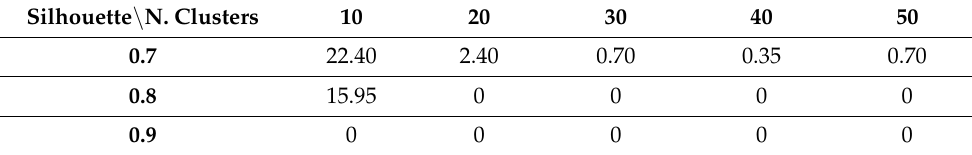
Table 31. Clustering performance in terms of silhouettes using original data. Silhouette \ N. Clusters